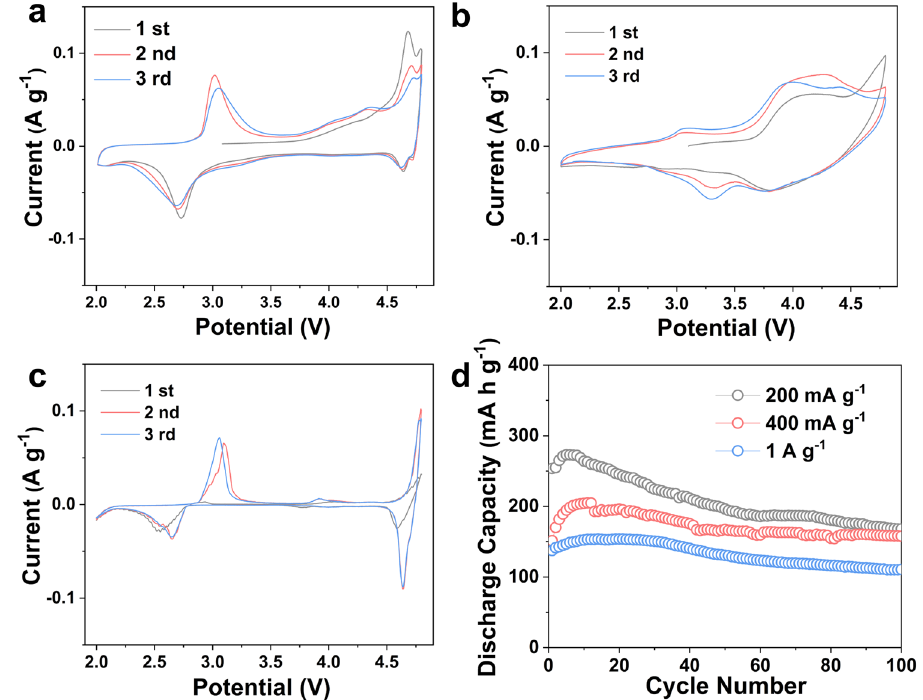
Fig. 5 | Cyclic voltammetry and cycling stability of various rocksalt-type tran- sition metal oxide materials. a – c The cyclic voltammograms from the fi rst three cyclesoftheLi||CD-LNMO( a ),Li||LLO( b ),andLi||LNMO( c )coincells. d Thecycling tests of Li||CD-LNMO cells at various speci fi c currents. CV measurements were